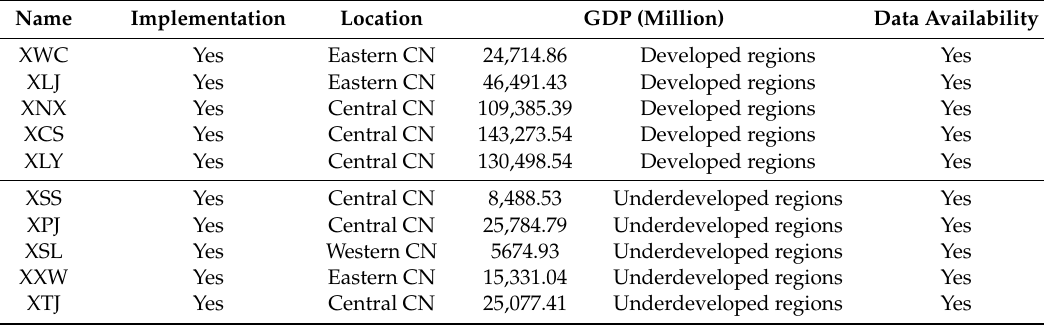
Table A1. Characteristics of Sample Cases.